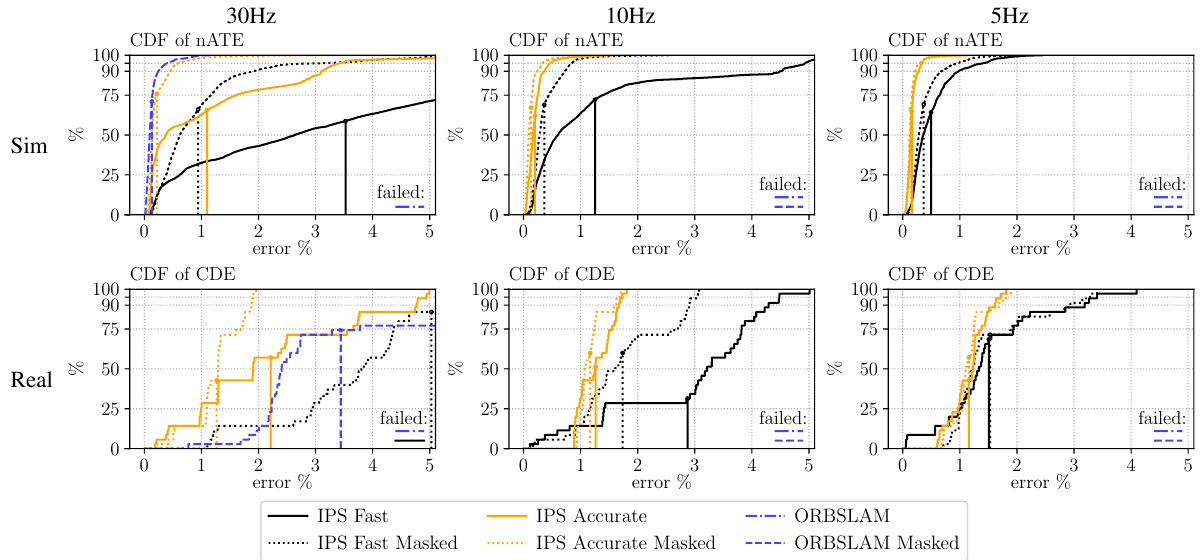
Figure 5. Results for the Corridor Dataset in CDF-representation, for different frame rates and for synthetic and real data respectively. The vertical lines mark the mean nATE or CDE respectively for each CDF. Navigation results that are considered as failed, are hidden. setup, but still included in our experiments to exploit the full potential of the segmentation aid. In IPS Fast Masked , the seg- mentation was applied on a downscaled image of (320 × 256 pixel) to investigate our method with less-effort